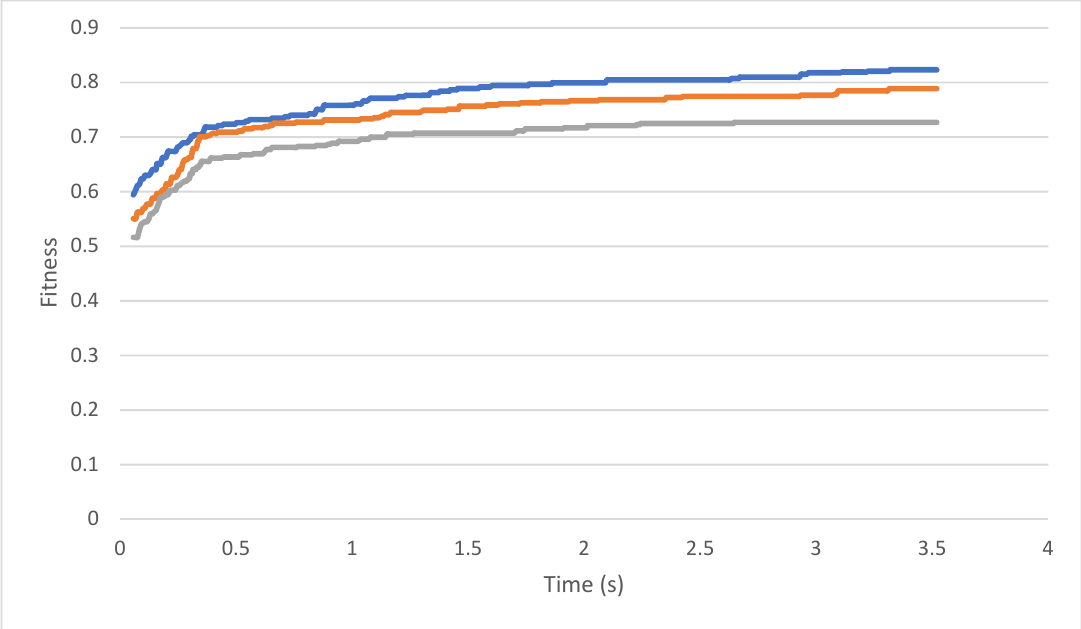
Figure 10. Semi-symmetric results.